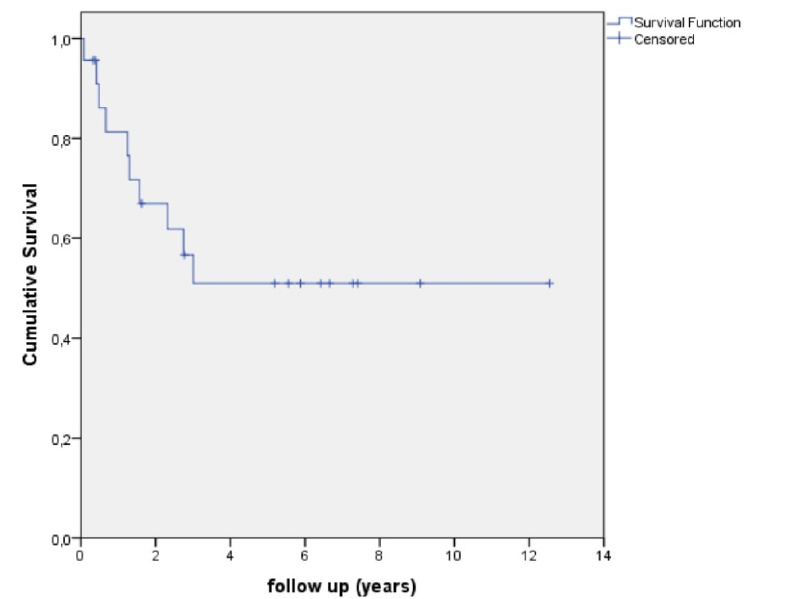
Figure 1. Kaplan-Meier curve showing survival/time without an event in the total